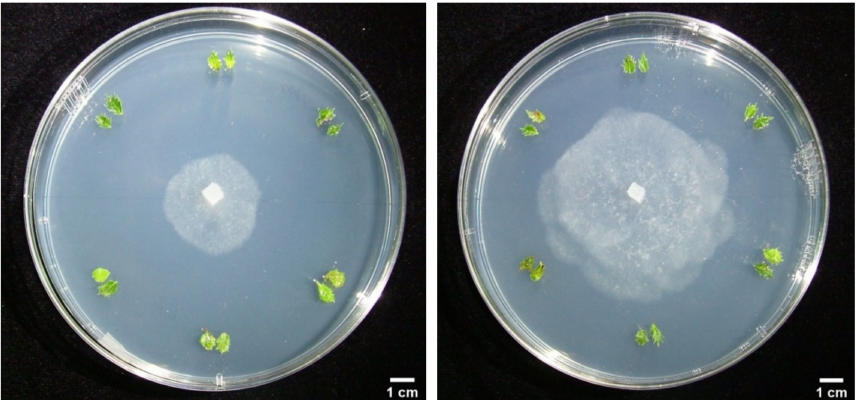
Figure 5. Growth of P. cinnamomi mycelia after 4 days ( left ) and after 7 days ( right ), towards leaves of the tolerant VA5 (up), and the E2 (bottom left) and E00 (bottom right) control